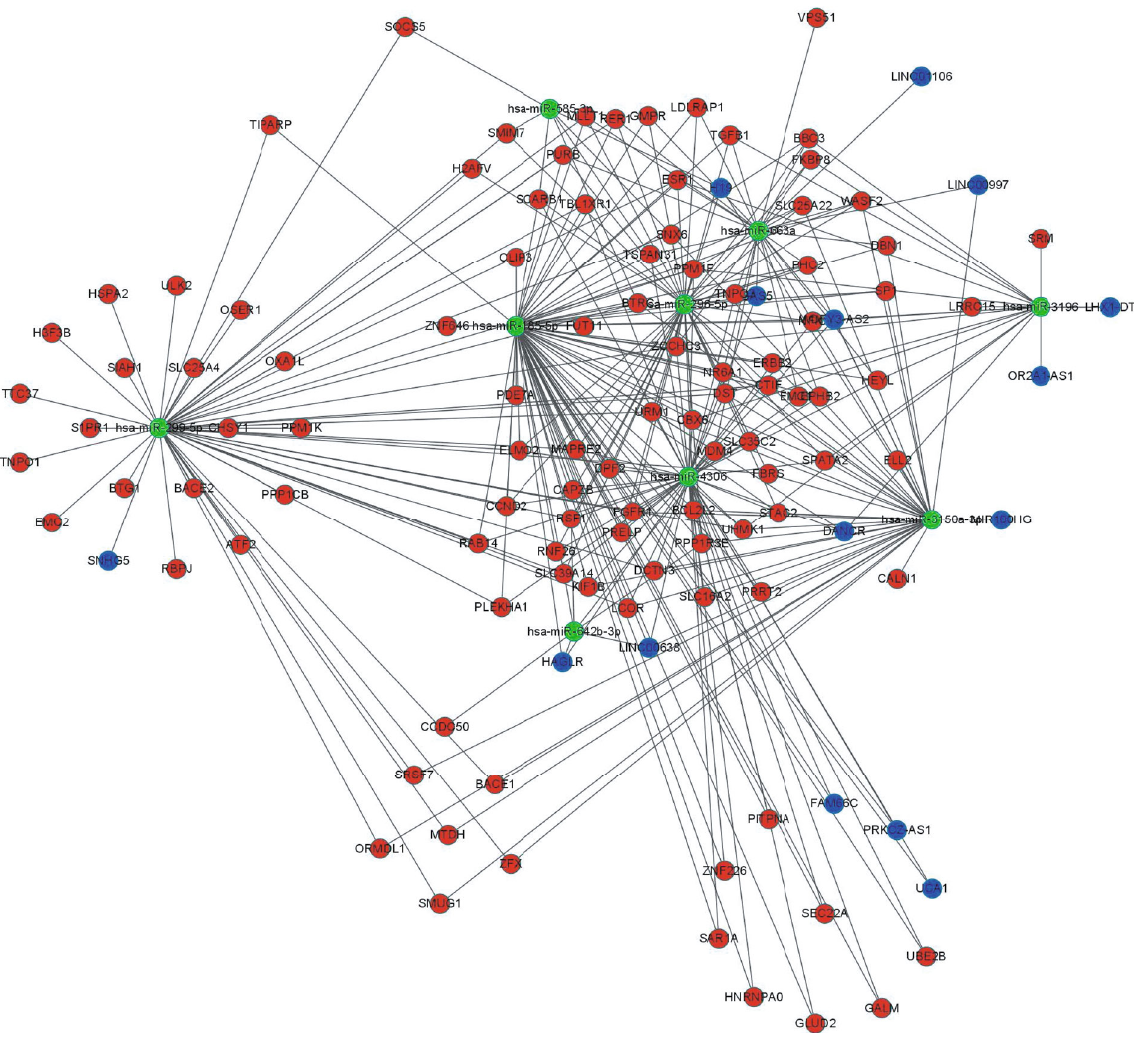
Figure 3: ceRNA network. The blue modules are lncRNA, the green modules are miRNA, and the red modules are